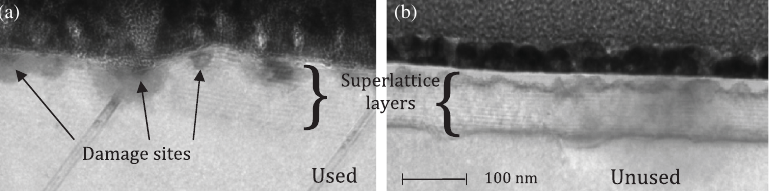
FIG. 7. TEM images of used (left) and unused (right) superlattice photocathode material. The dark areas at the top are the Au/Pd and Pt protective layers. The 100 nm thick superlattice of 3 and 4 nm layers of GaAs/GaAsP can be seen. The used cathode shows deep ‘‘stains’’, which are not evident in the unused sample on the right. Blurring at the top of the unused cathode is due to a slight tilt during TEM imaging which images the gold overlayer as well as the cathode.